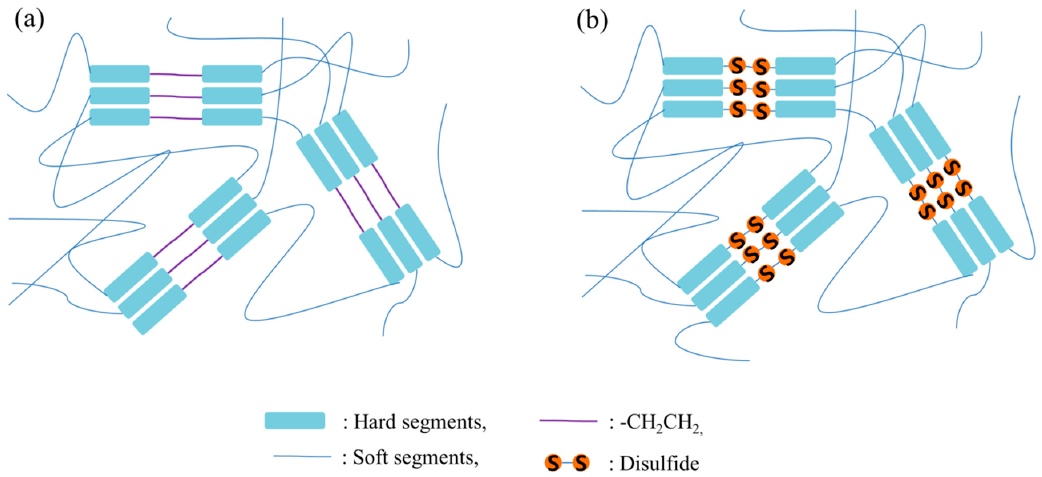
Figure 1. Schematic of microphase separated WPU films: ( a ) WPU-EDA; ( b ) WPU-cystamine.